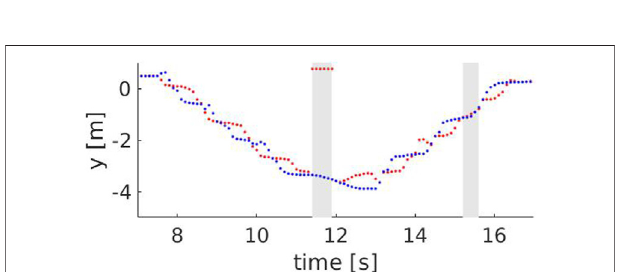
FIGURE 8 | The y component of the left (red) and right (blue) ankle for a speedof1.3m/ s . Thegrey areas showtime intervals where stepsaremissed, i.e between 11.4 and 11.9 s (skeleton falling out of the fi eld of view) and between 15.2 and 15.6 s (skeleton is too far from the robot).